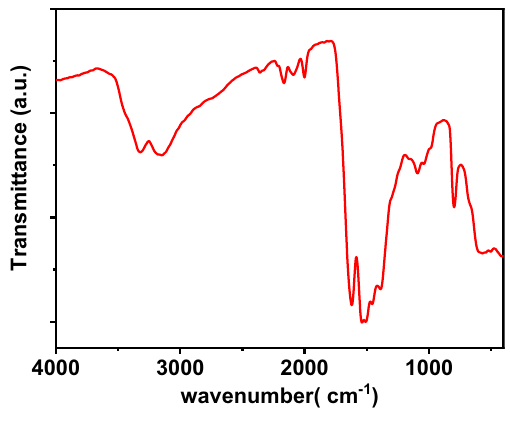
Fig. 6 FTIR spectrum of CdS sample